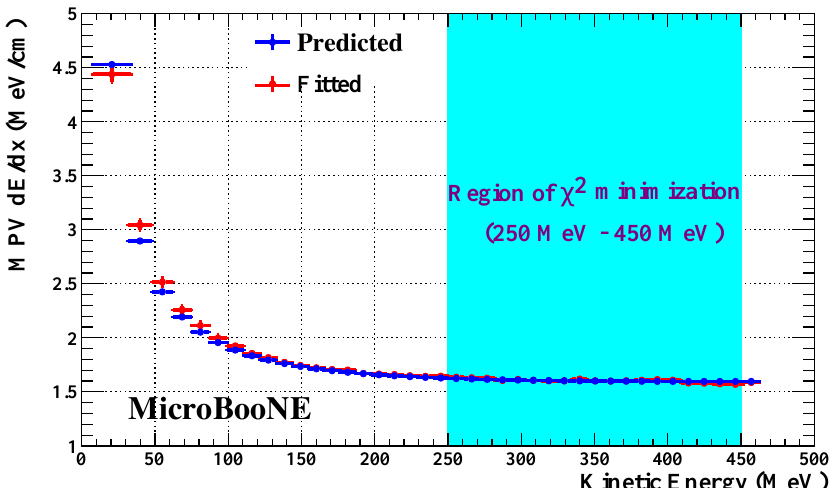
Figure 8. Comparison between the predicted and the measured most probable value of dE / dx for stopping muons in MicroBooNE data. This figure is from